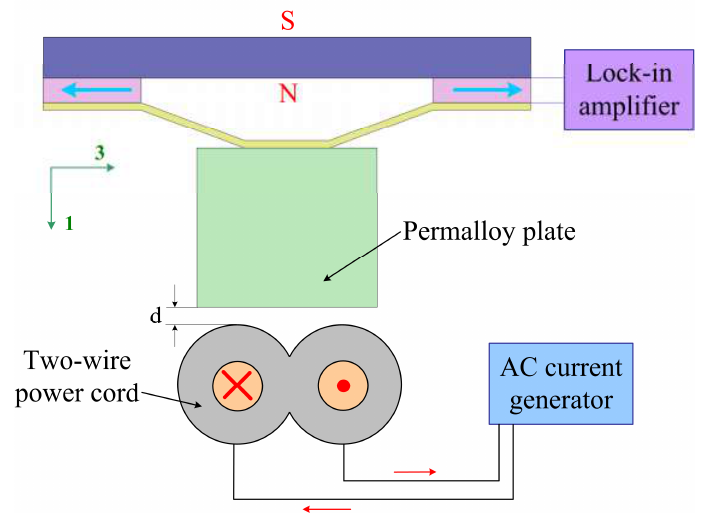
Figure 3. Configuration and experimental set-up for the proposed device.